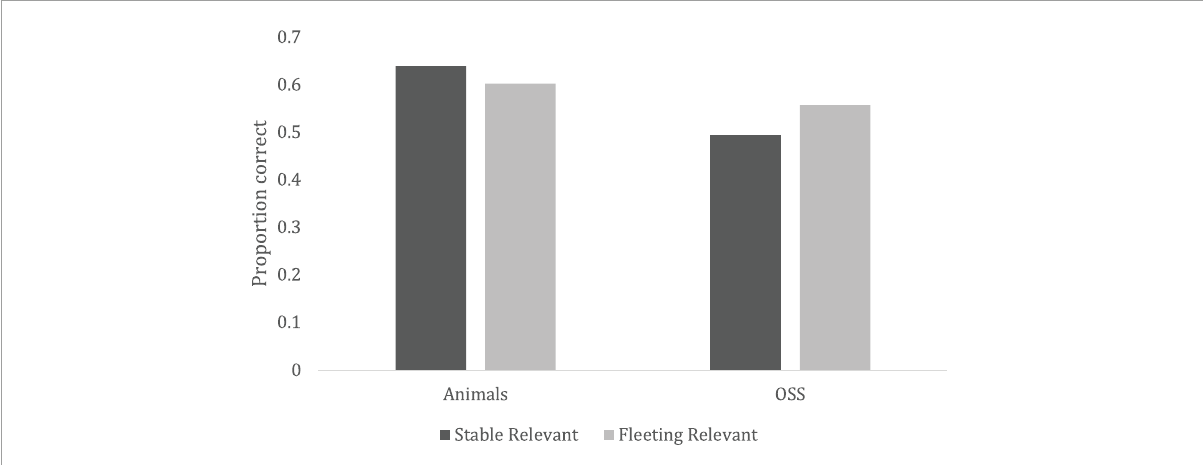
FIGURE1 Change detection accuracy as a function of stability (Fleeting vs. Stable), and animacy (Objects, Substances, and Surfaces (OSS) vs. Animal).